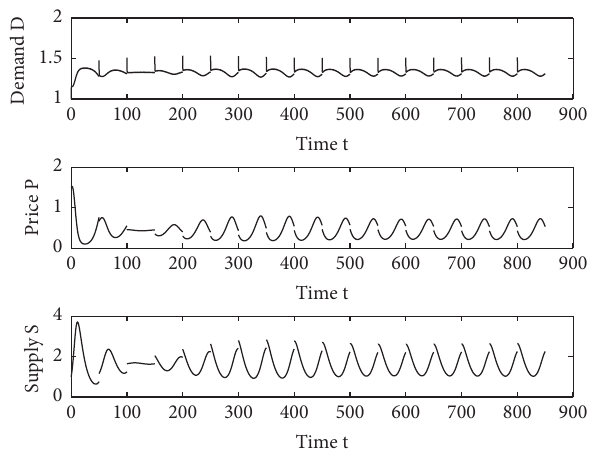
Figure 5: Numerical simulation diagram of impulsive differential dynamic system According to the comparison principle,